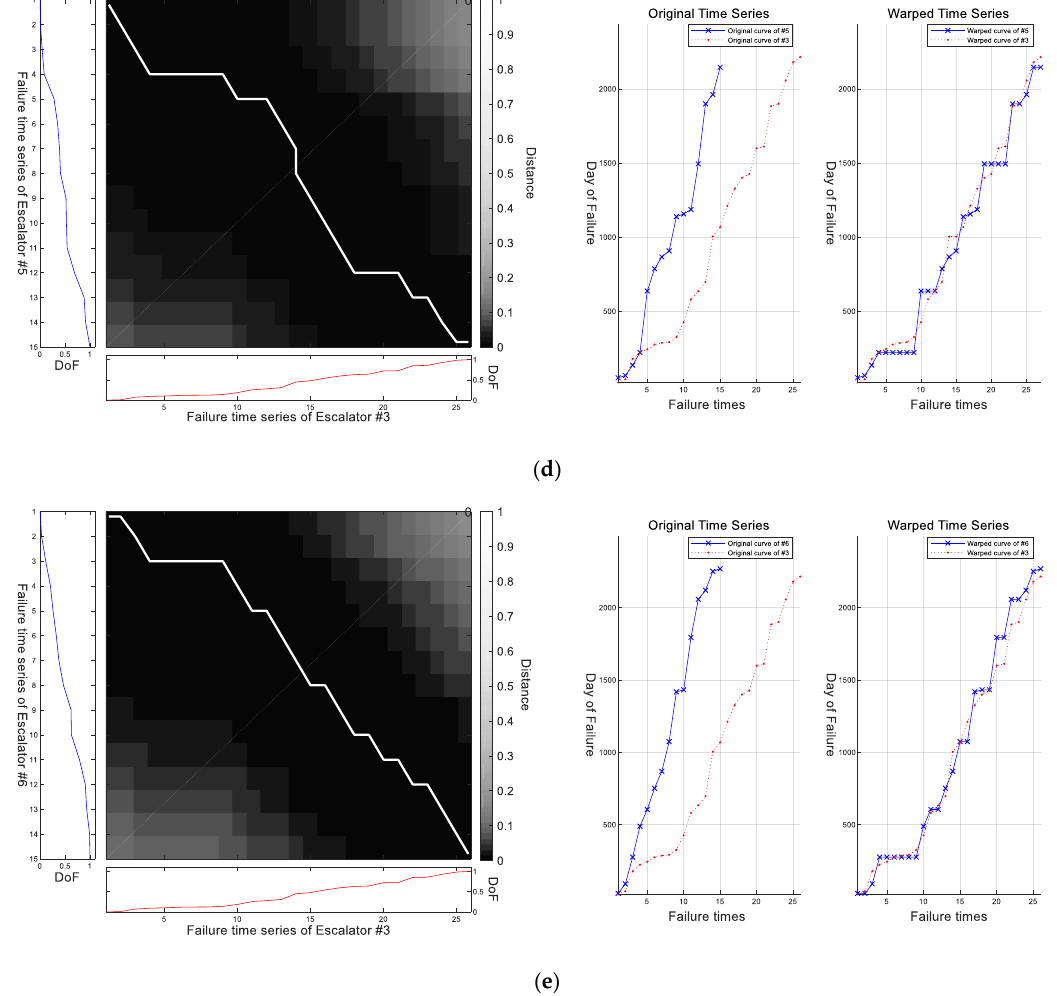
Figure 10. DTW preprocessing results. ( a ) Warped failure time series of #1. ( b ) Warped failure time series of #2. ( c ) Warped failure time series of #4. ( d ) Warped failure time series of #5. ( e ) Warped failure time series of #6.